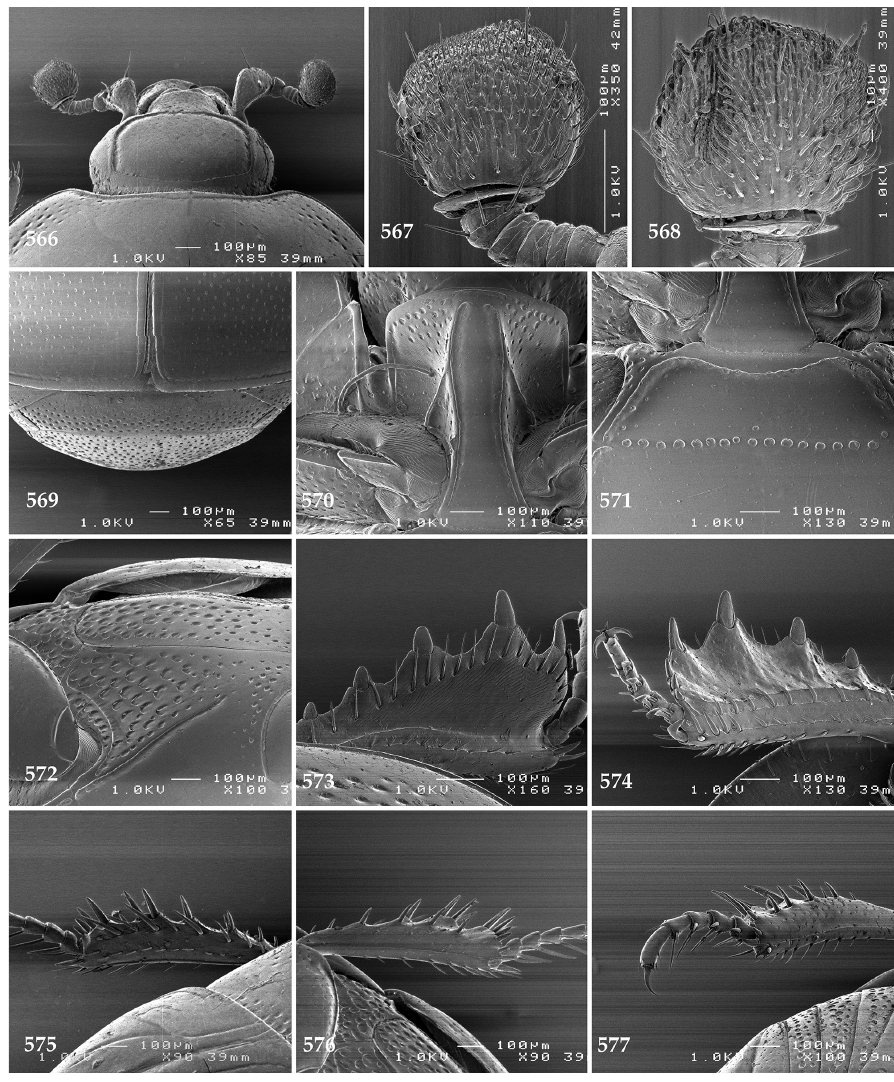
Figures 566–577. 566 Saprinus ( Saprinus ) tyrrhenus Blackburn, 1903 head, dorsal view 567 antennal club, dorsal view 568 ditto, ventral view 569 propygidium + pygidium 570 prosternum 571 mesoven- trite 572 lateral disc of metaventrite + metepisternum 573 protibia, dorsal view 574 ditto, ventral view 575 mesotibia, dorsal view 576 ditto, ventral view 577 metatibia, ventral